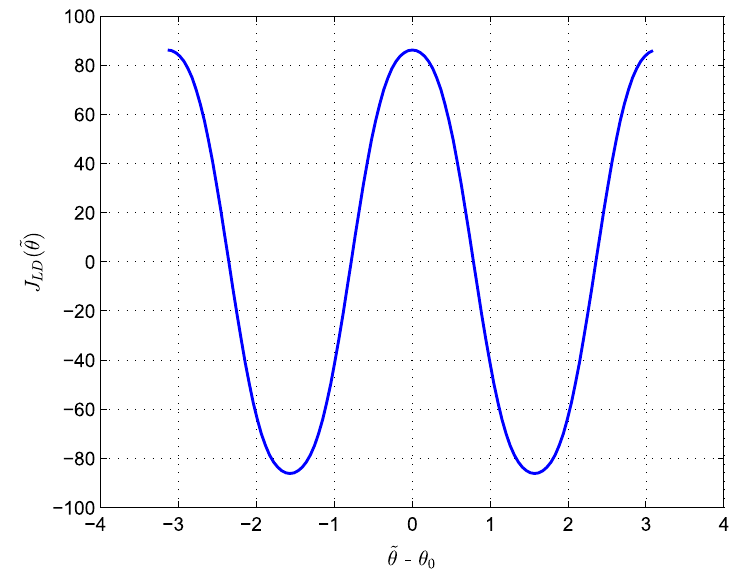
Fig. 3 J LD ( ˜ θ) curve versus the phase offset estimation error ˜ θ − θ 0 in a noise-free